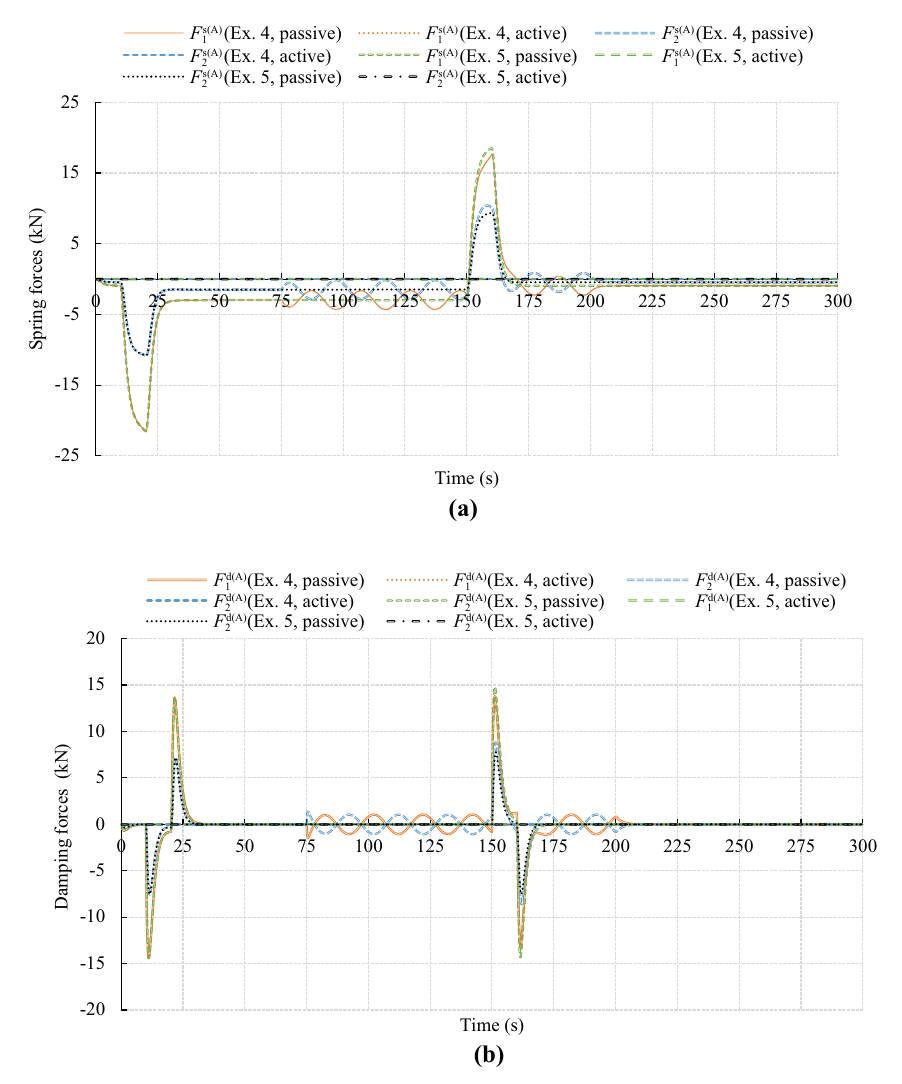
Fig. 10 Response action of the passive and active vibration damping systems: a coupler spring forces F s A ð Þ damping forces F d A ð Þ and F d A ð Þ vs. 1 2